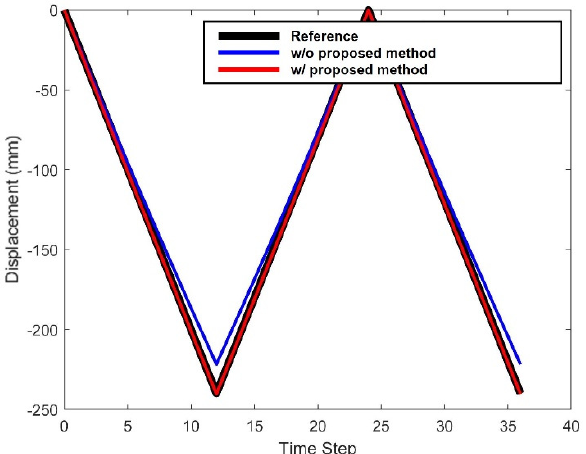
Figure 13. Estimated displacement for the lab-scale validation test.